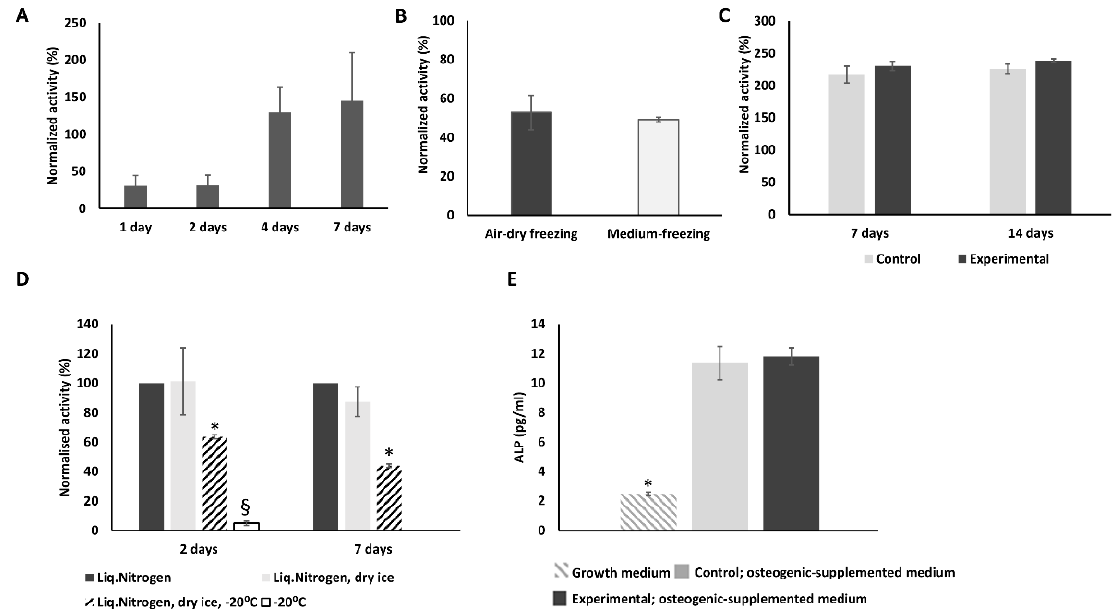
Figure 1. hMSCs preseeded on scaffolds retain their metabolic activity after cryopreservation. ( A ) Metabolic activity of MSCs was measured 1, 2, 4, and 7 days after cryopreservation, shown in % of control cells metabolic activity. MSCs were preseeded on scaffolds 48 h prior to cryopreservation. ( B ) There was no significant difference in metabolic activity of hMSCs processed with two different cryopreservation protocols and measured 2 days after cryopreservation. ( C ) Metabolic activity of control and experimental cells at 7 and 14 days of culture in osteogenic supplemented medium showed no significant differences. ( D ) hMSCs were first cryopreserved in liquid nitrogen and either stored for 3 days on dry ice or stored for 3 days on dry ice and 1 day at − 20 °C. The metabolic activity of cells was measured at days 2 and 7 post-thaw and is shown in % of metabolic activity of cells stored in liquid nitrogen only. ( E ) ALP expression is significantly enhanced in both, control and experimental group cells at day 7 of culture in osteogenic-supplemented medium, as compared to cells cultured in growth medium. (* p < 0.05, § p < 0.01).